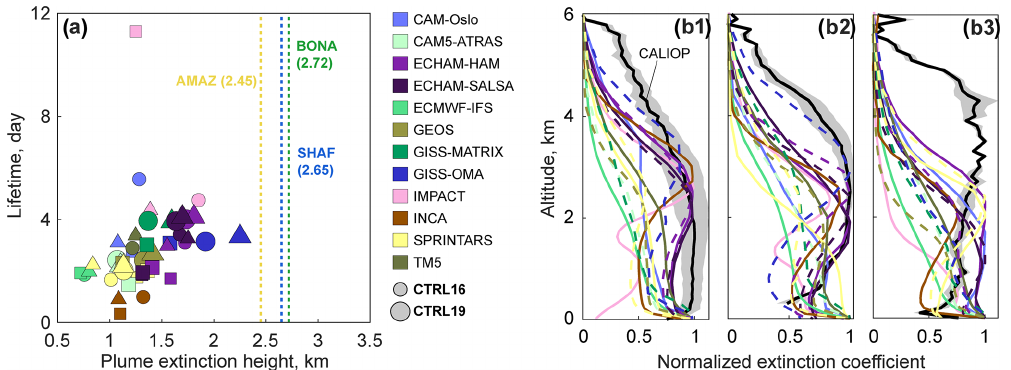
Figure 12. Variation in modeled plume height (a) and validation of modeled aerosol vertical profile against CALIOP for AMAZ ( b1 ), SHAF ( b2 ), and BONA ( b3 ). The color scheme in b1–b3 is the same as in (a) , with the solid and dashed lines showing the model data from CTRL16 and CTRL19 experiments (if both are available for the same model), respectively. The gray-shaded areas in (b) show the ± σ ranges for the CALIOP